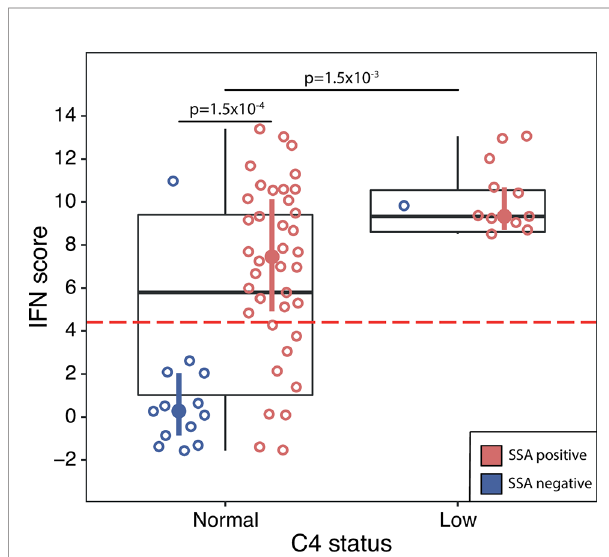
FIGURE 4 | DNAm IFN score levels in pSS patients with normal C4 status (left box) compared with pSS patients with low C4 status (right box), discovery and replication cohort together. Dotted red horizontal line indicates threshold for high IFN score. Boxes represent median and interquartile range, whiskers indicate total range. Patients positive for SSA antibodies are indicated by red open circles, patients negative for SSA antibodies by blue open circles. IFN score median and interquartile range for pSS patients strati fi ed on SSA status are indicated by red (SSA positive pSS) and blue (SSA negative pSS) fi lled circles and vertical lines, respectively. Differences between groups were assessed using Mann-Whitney U